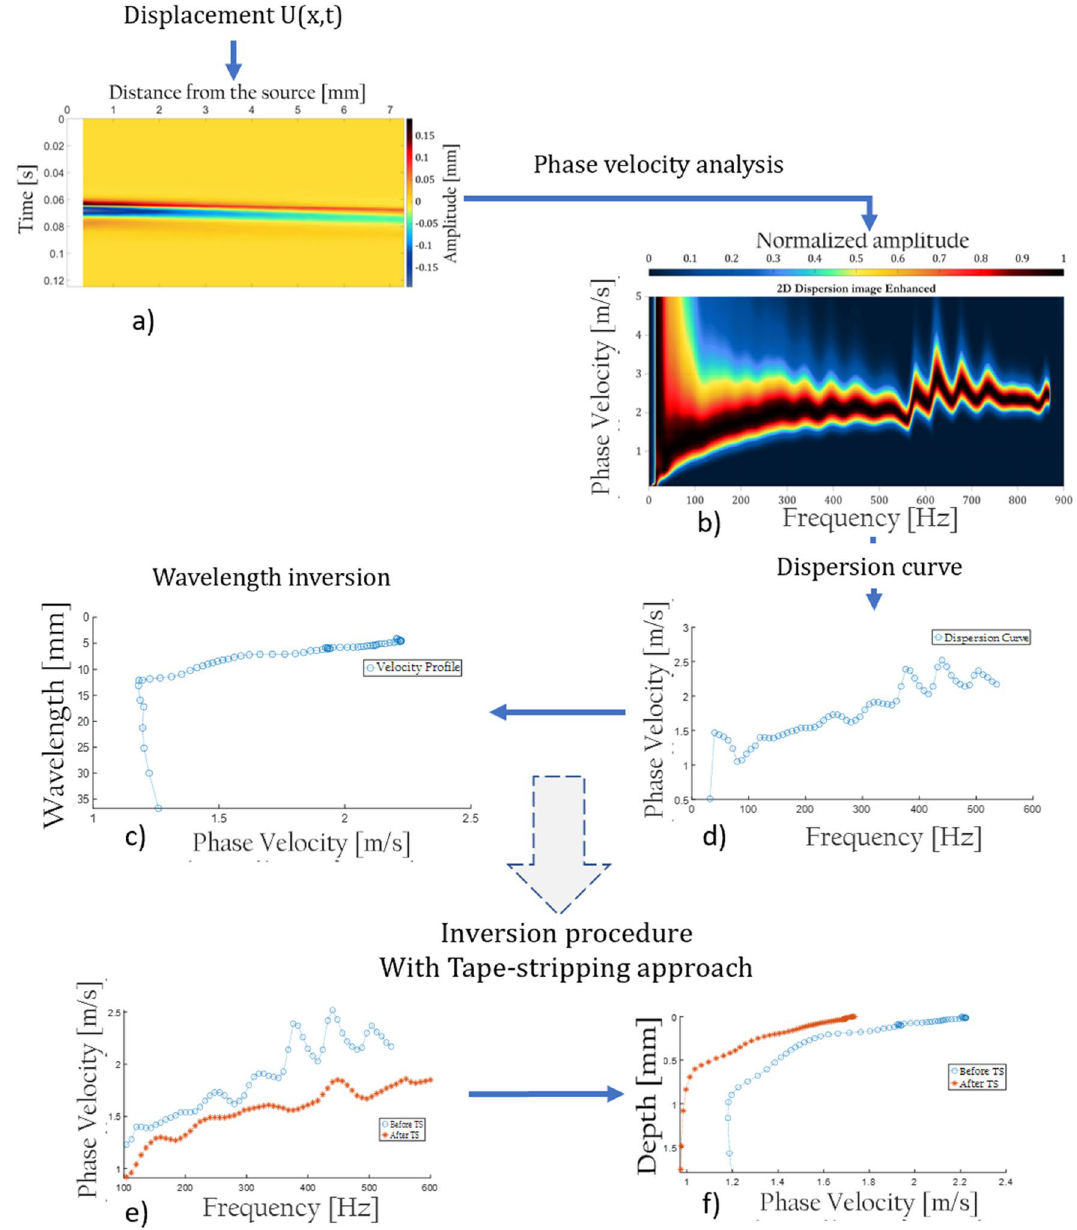
Figure 5. ( a ) Recorded wavefield; displacement as a function of time and the distance from the source—blast of air. ( b ) Dispersion image resulting from MASW algorithm. ( c ) Dispersion curve extracted from the dispersion image. ( d ) Phase velocity as a function of the wavelength. ( e ) dispersion curves outcome before and after tape- stripping so as to elaborate the inversion model. ( f ) Phase velocity as a function of the depth employing the established inversion